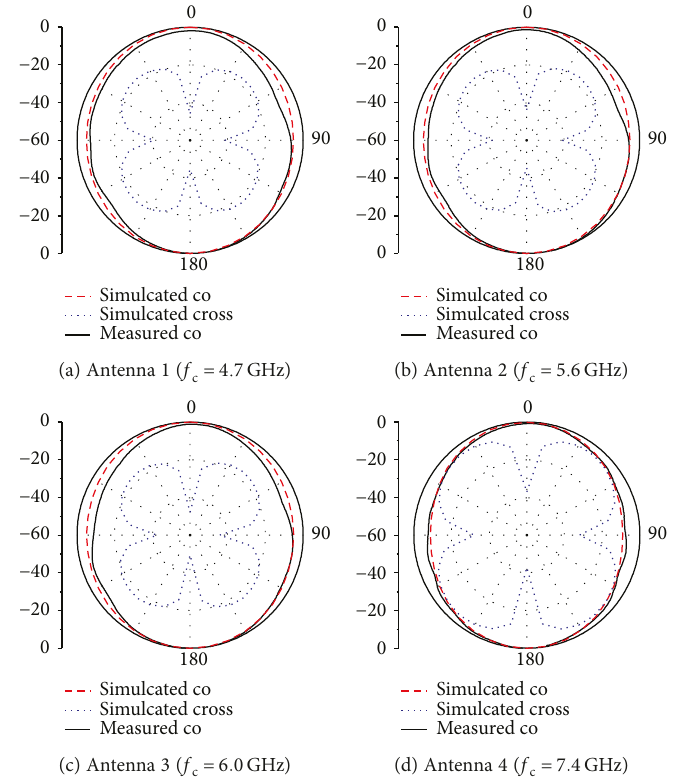
Figure 12: Simulated and measured radiation patterns in the H-plane ( y - z